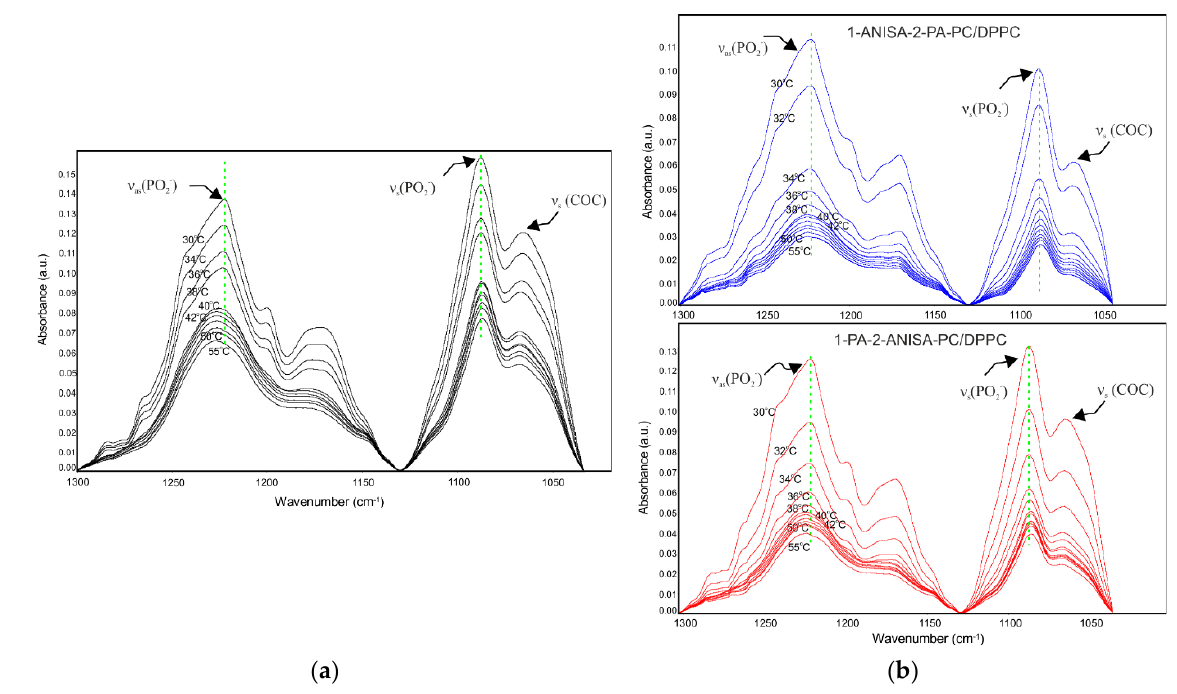
Figure 7. ATR − IR spectra of hydrated DPPC bilayer ( a ) and hydrated 1 − ANISA − 2 − PA − PC/DPPC and 1 − PA − 2 − ANISA − PC/DPPC bilayer ( b ) in the region between 1300 − 1040 cm −1 at different temperatures; the conju- gate:DPPC molar ratio of 1:5.